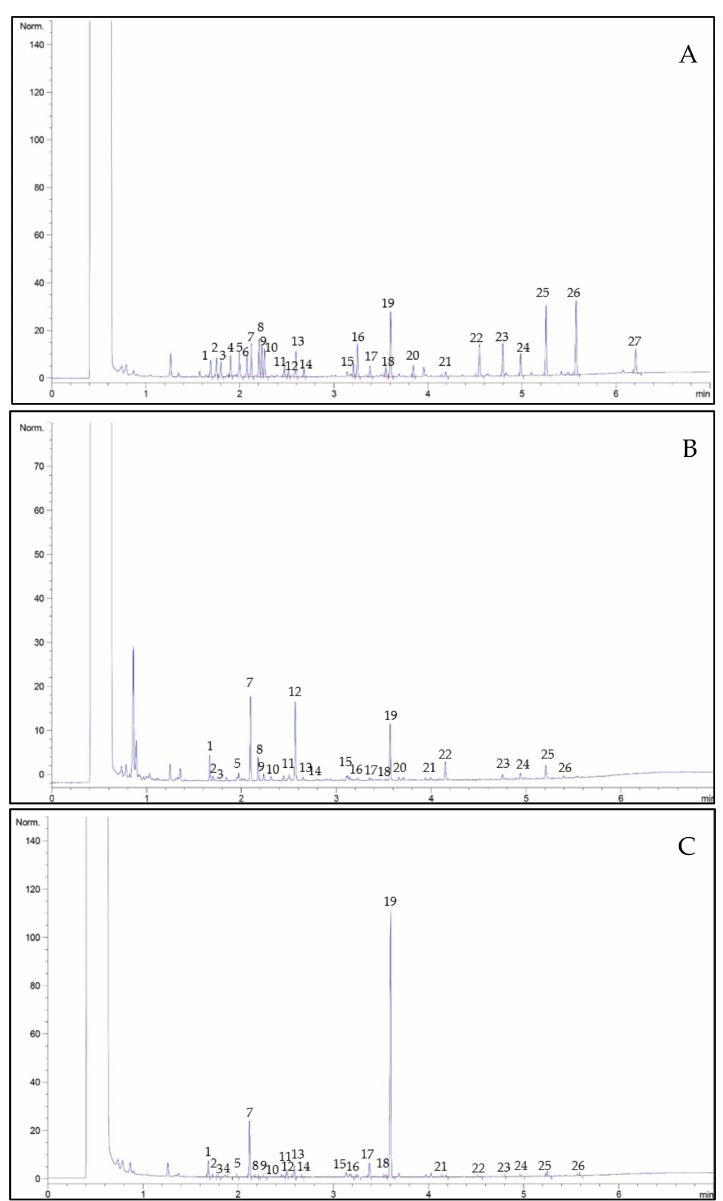
Figure 1. Representative gas chromatography flame-ionisation detection (GC-FID) chromatogram of amino acids standard mixture (100 umol / L) ( A ); Apis honey ( B ) and starfruit honey ( C ). For peak identification, 1 = Alanine; 2 = sarcosine; 3 = glycine; 4 = α -Aminobutyric acid; 5 = Valine; 6 = β -Aminoisobutyric acid; 7 = IS; 8 = Leucine; 9 = Allo-isoleucine; 10 = Isoleucine; 11 = Threonine; 12 = Serine; 13 = Proline; 14 = Asparagine; 15 = Aspartic acid; 16 = Methionine; 17 = 3-hydroxyproline; 18 = glutamic acid; 19 = Phenylalanine; 20 = α -Aminoadipic acid; 21 = Glutamine; 22 = Ornithine; 23 = Lysine; 24 = Histidine; 25 = Tyrosine; 26 = Tryptophan; 27 = Cysteine. Proline was significantly higher in Apis honey compared to stingless bee honey samples, while allo-isoleucine, cysteine, β -aminoisobutyric acid, and α -aminobutyric acid were not detected in